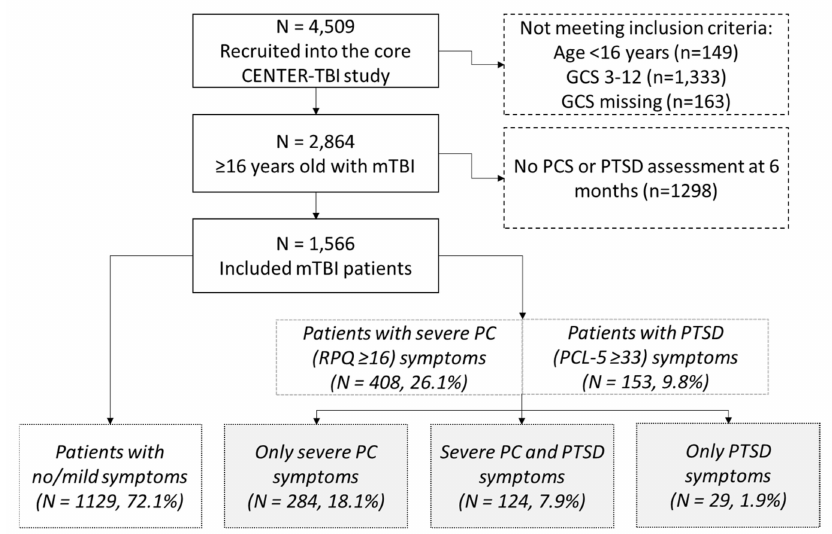
Figure 1. Flow chart. n = number; mTBI = mild traumatic brain injury; PCS = post-concussion symptoms; PTSD = post-traumatic stress